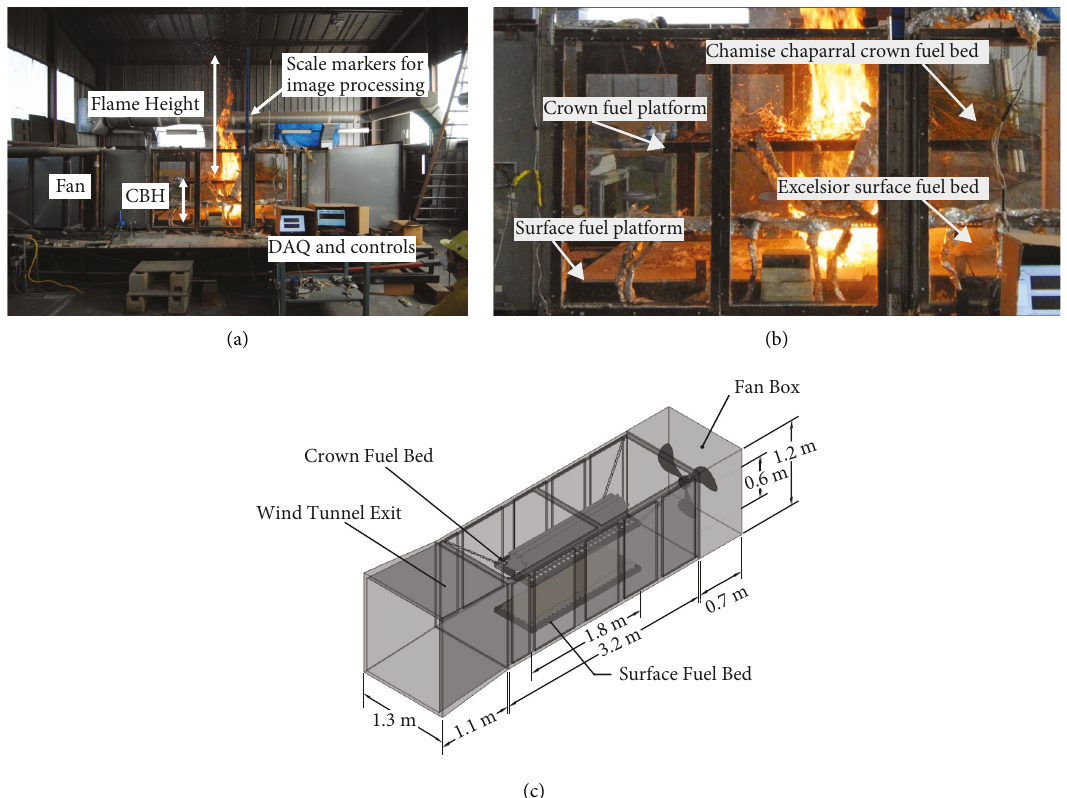
Figure 1: Experimental setup for wind tunnel experiments, from top to bottom: (a) complete experimental setup showing the location of the wind tunnel fan, data acquisition system (DAQ) and controls, crown base height (CBH) distance, flame height, and metal bar with markers used as a scale during image processing, (b) a close-up view of the test section showing the location of the crown fuel bed platform, chamise chaparral fuels, surface fuel bed platform, and excelsior surface fuels, and (c) schematic with part labels and